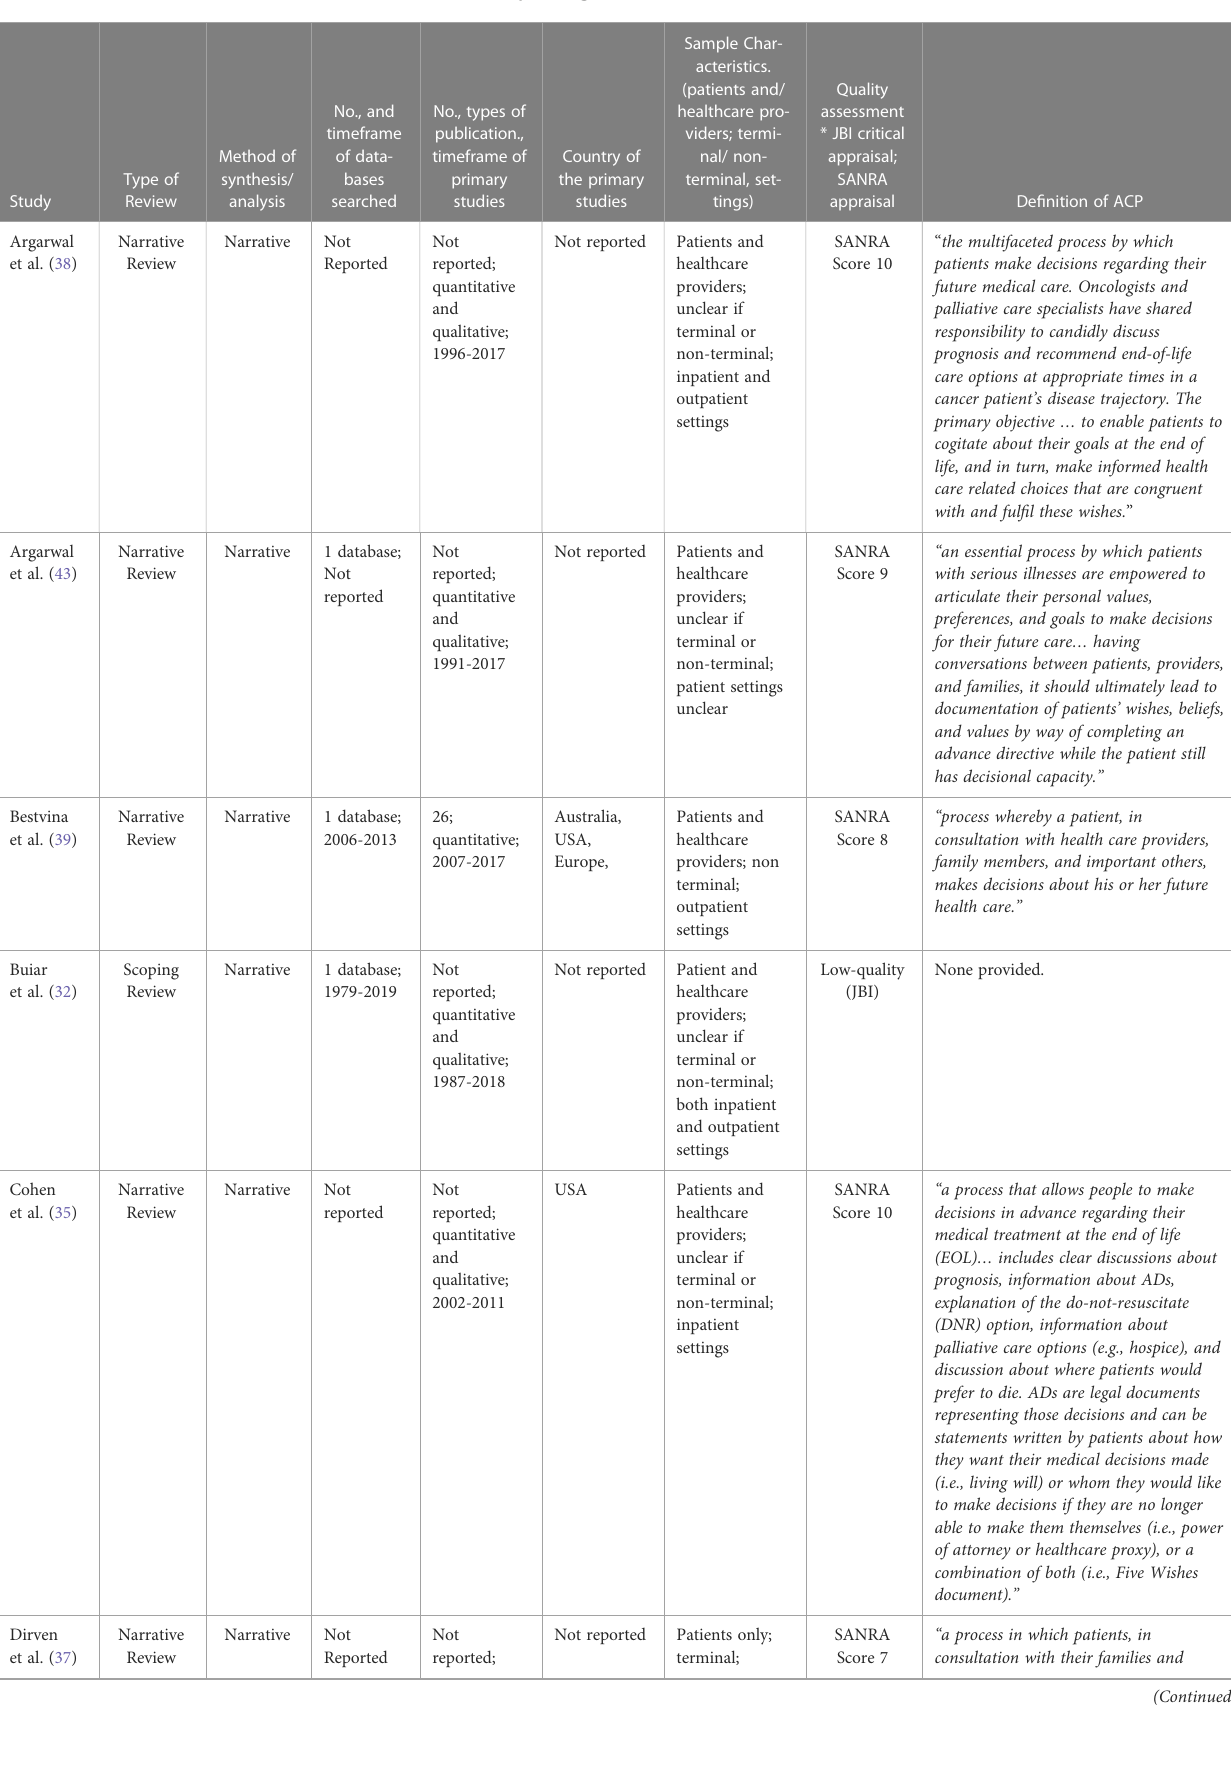
TABLE 1 Characteristics of included reviews and advance care planning (ACP) de fi